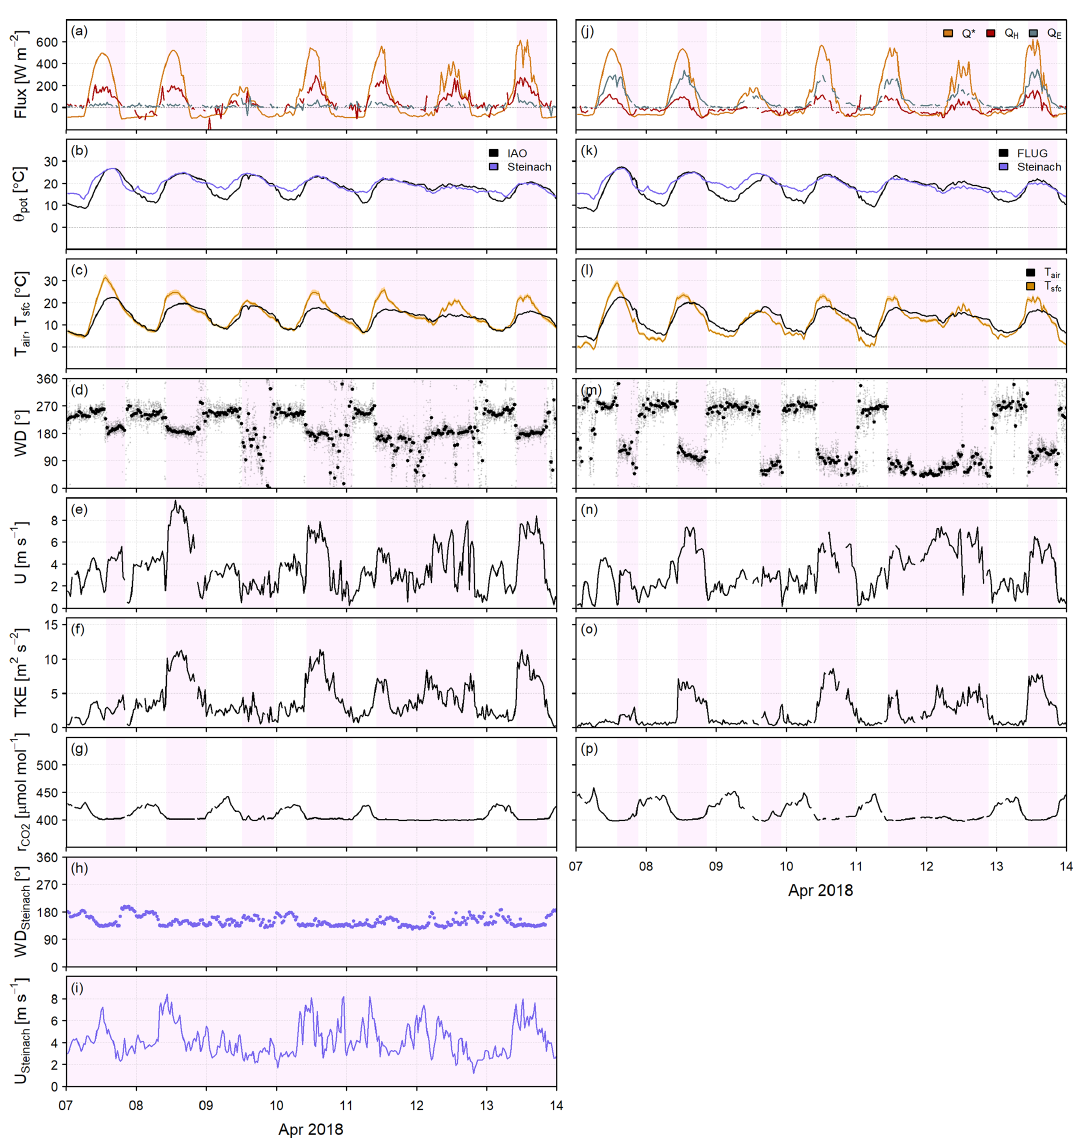
Figure 8. As in Fig. 6 for the period 7–14 April 2018 at (a–g) IAO, (j–p) FLUG and (h–i)